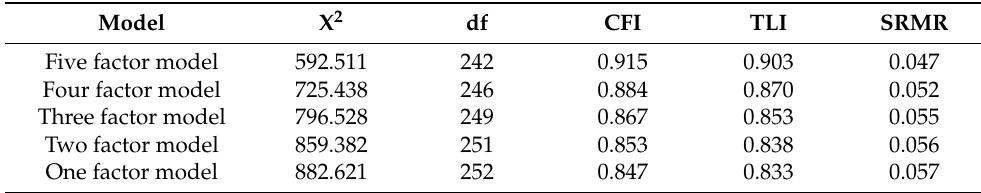
Table 3. Confirmatory factor analysis